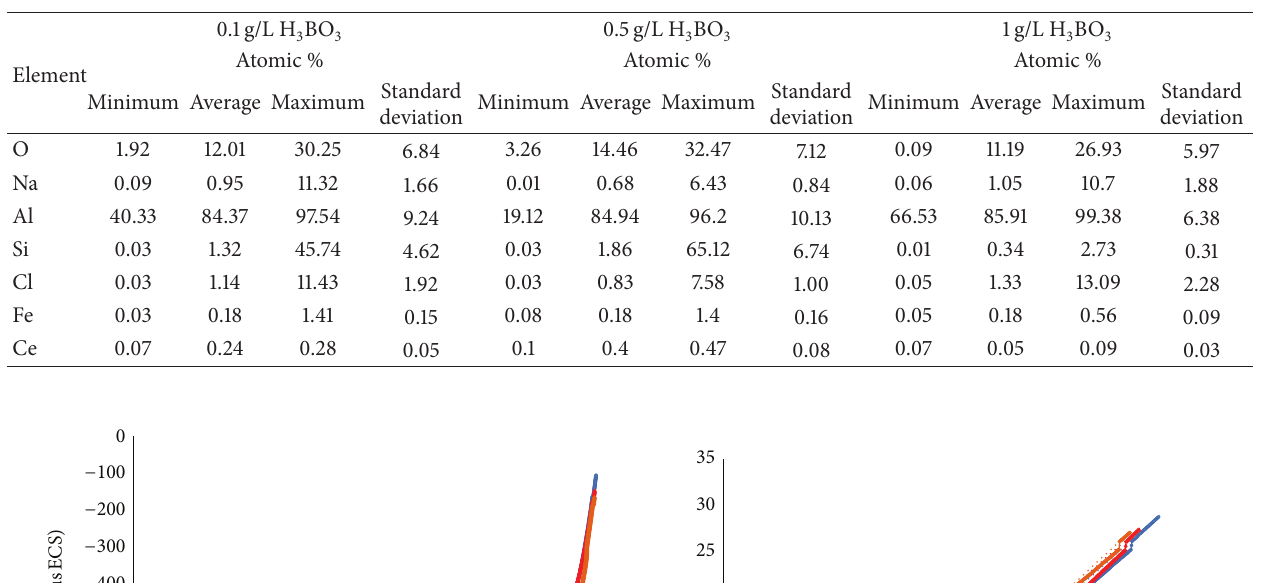
Table 3: Statistical treatments of 220 test of EDS analysis.